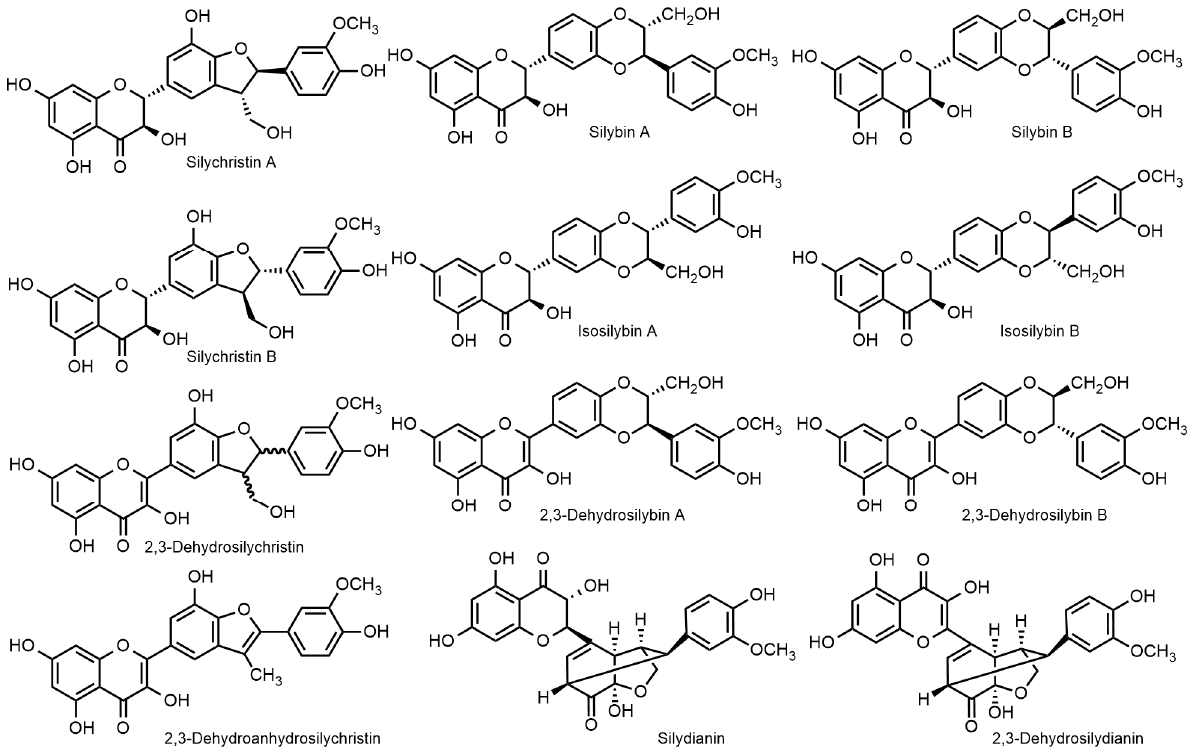
Figure 1. Major flavonolignans of silymarin.